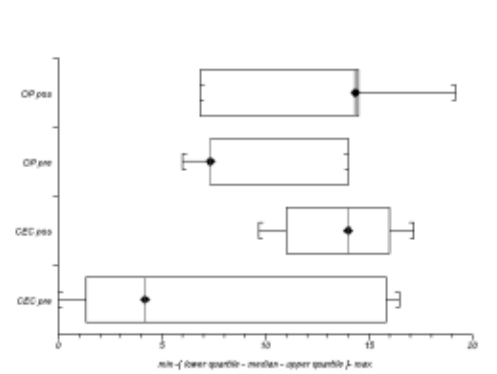
correct manner of intervention in the process still needs to be better elucidated, in a way that only the deleterious effects can be lessened and the physiologic function preserved. The findings point to further evidence of the aggression that CPB can create in relation to homeostasis of the individual. Consequently, a favorable factor can be added for the greater implementation of Off-pump CABG surgery, as this investigation supplies data implicating the use of the heart-lung machine and the exposition of human blood to non-endothelium surfaces to deleterious effects of the physiopathology of the systemic response in Off-pump CABG